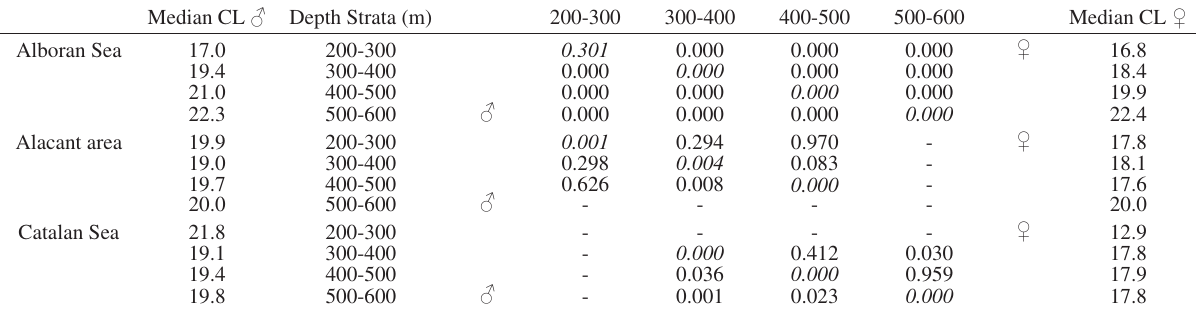
Fig. 7. – Size frequency distributions of male (dark bars) and female (white bars) Pasiphaea sivado by 100 m depth strata. The number of measured individuals by gender (N) is shown. Strata with fewer than 100 measured individuals are not shown since the low number by sex was considered to be not relevant. Table 3. – Comparison of median sizes (carapace length, CL; in mm) among 100 m depth strata within each geographic population. The obtained Mann-Whitney p values for the comparison between females are presented above the diagonal, between males below the diagonal and between genders within each depth stratum along the diagonal (values in